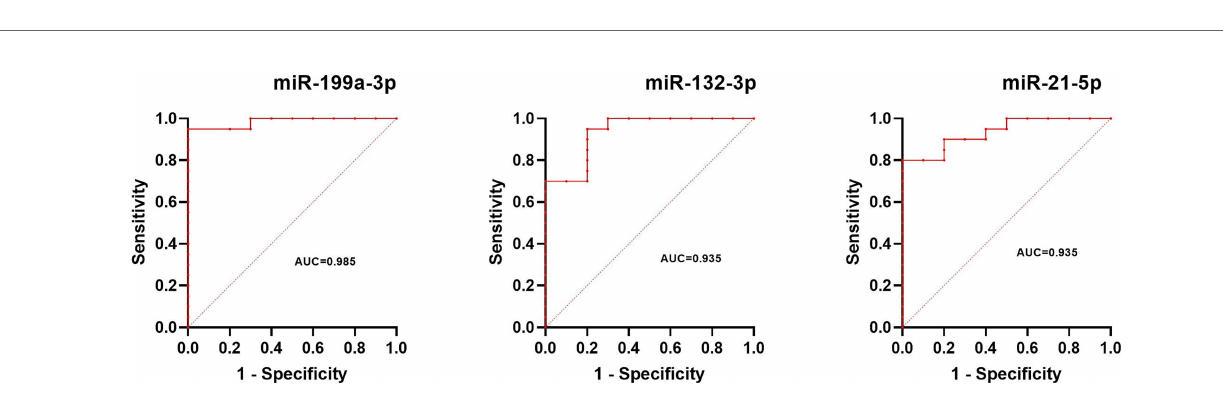
FIGURE 5 | Results of ROC analysis of miR-199a-3p, miR-132-3p, and miR-21-5p between UM patients and healthy controls.